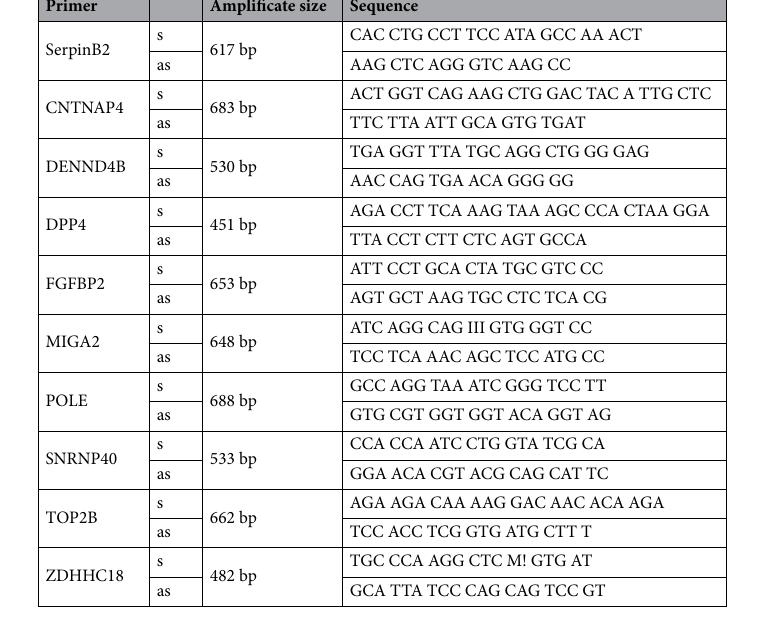
Table 2. List of the used primer and their sequences. S = sense; AS =